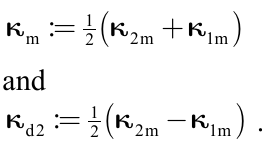
and r are the radii of curvature. t is the thickness. S 2 1